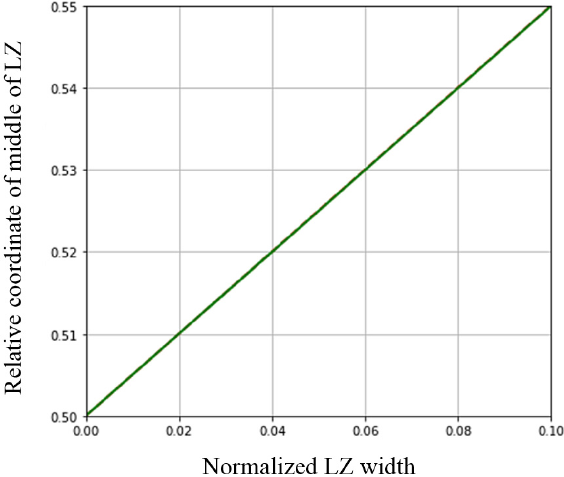
Figure 10. The results of the determination of the coordinates of the middle of the light zone by a video signal 𝑣(𝑡̂) .